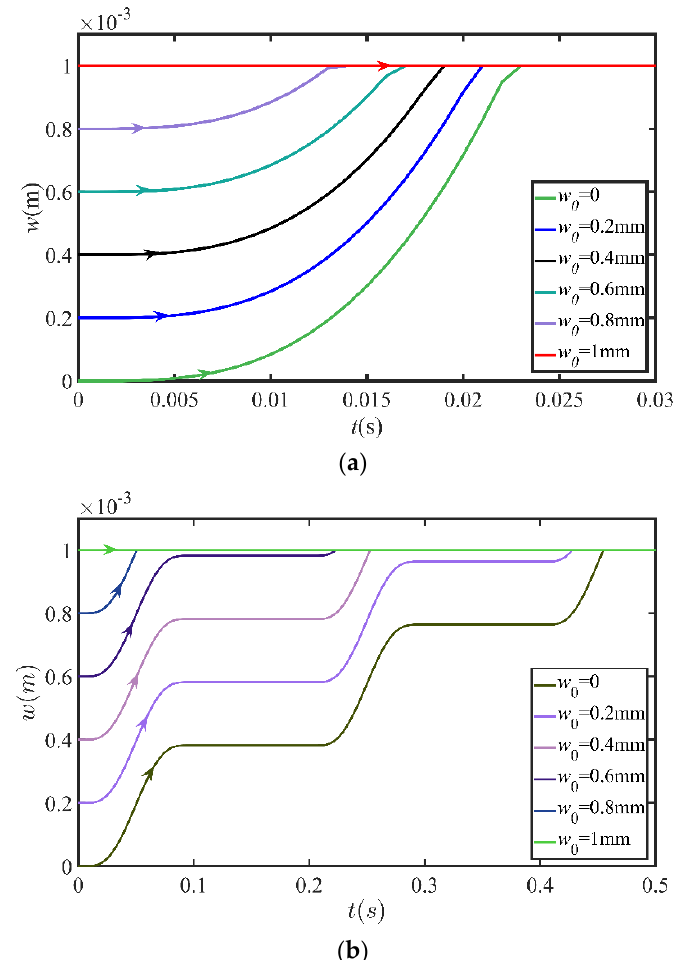
Figure 10. Sinusoidal signal v m ( t ) = V 0 sin ( 2 π ft ) , with f = 5 Hz and V 0 = 0.5 V as the AC excitation and applied to the memristor ( a ) can be obtained, ( b ) corresponds to V 0 = 0.1